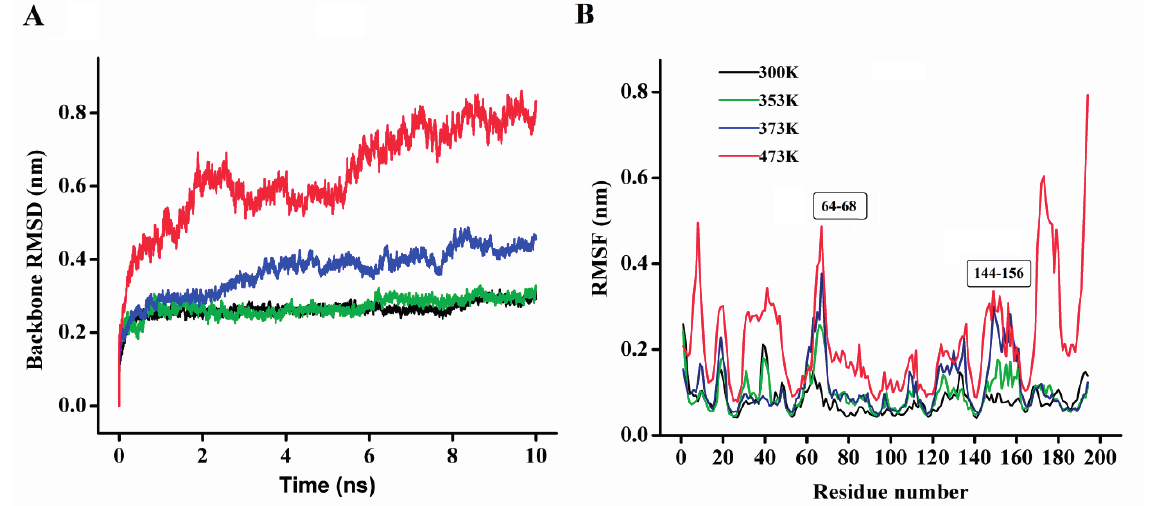
Figure 8. ( A ) The rmsd values for the backbone atoms of P186_1588 during 10 ns simulation at different temperatures; ( B ) The rmsf values of the residues in P186_1588 at different temperatures. The color-coding scheme is as follows: 300 K (black), 353 K (green), 373 K (blue) and 473 K